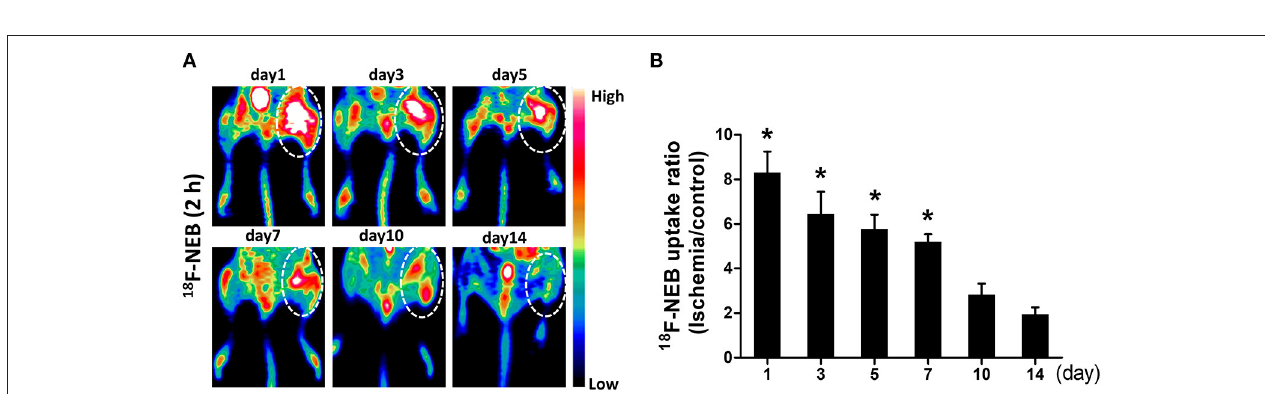
FIGURE 4 | Vascular permeability in ischemic limb was monitored by PET imaging. (A) representative coronal images of PET scan 2h after 18 F-NEB tracer injection at day 1, day 3, day 5, day 7, day 10 and day 14 post surgery, respectively. (B) Analysis of PET data to determine the uptake ratio of 18 F-NEB tracer within ischemic right limb and control left limb at a serial of time points ( * P < 0.05, vs. day